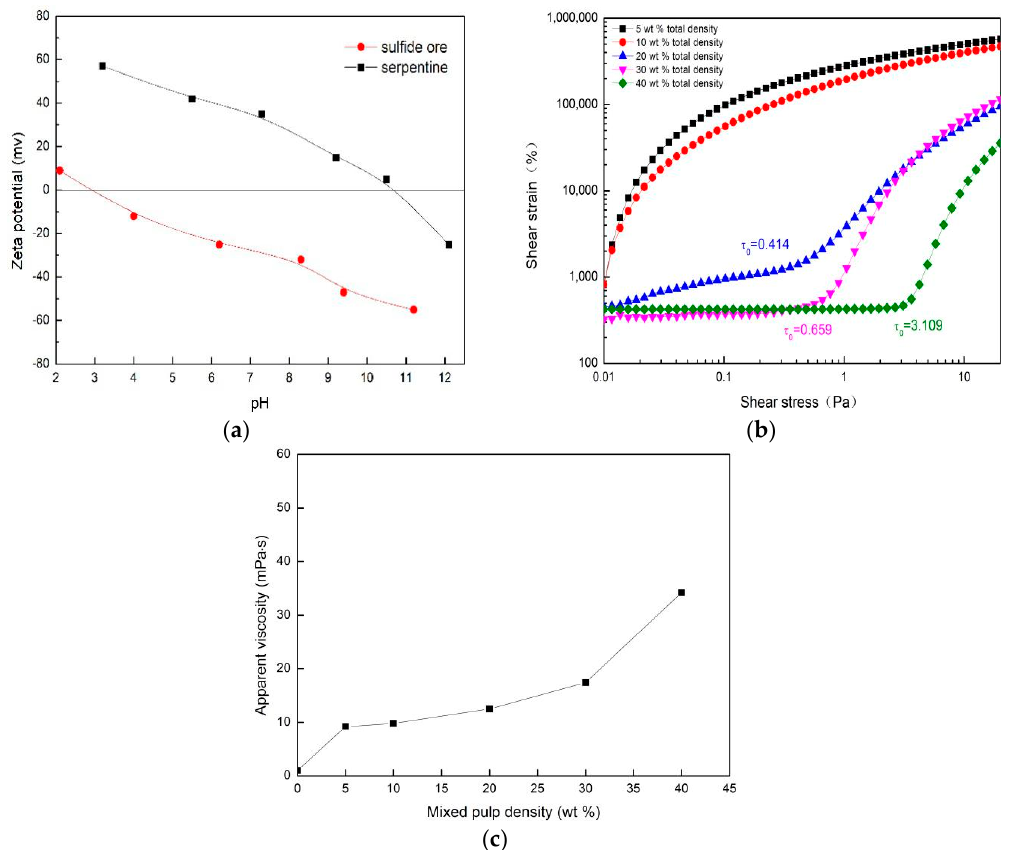
Figure 3. Zeta potential of minerals as a function of: ( a ) pH; ( b ) the shear stress vs. shear strain; ( c ) apparent viscosity of mixture at the shear rate of 100 s − 1 for both the sulfide ore and serpentine (1:1) at different total solid density from 5 wt % to 40 wt %.